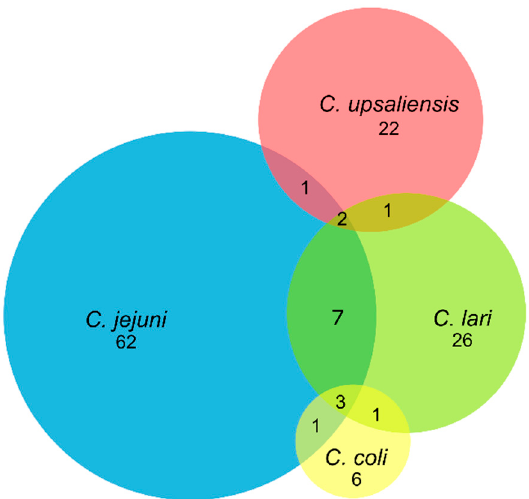
Figure 2. Venn diagram representing thermophilic Campylobacter spp. carried in pets (dogs and cats) from France. Numbers represent the number of pets carrying Campylobacter species. When an overlap is observed between two or more circles representing Campylobacter species, it means a co-infection of pets by these Campylobacter species.